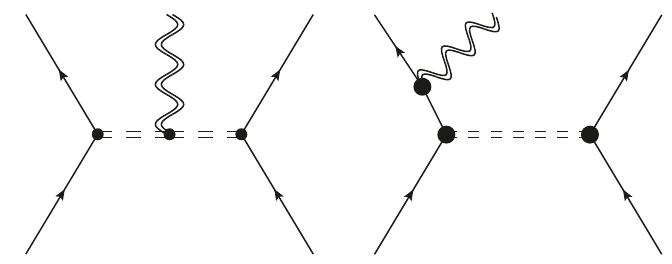
Figure 5. Types of diagram with only intermediate, virtual, dilaton